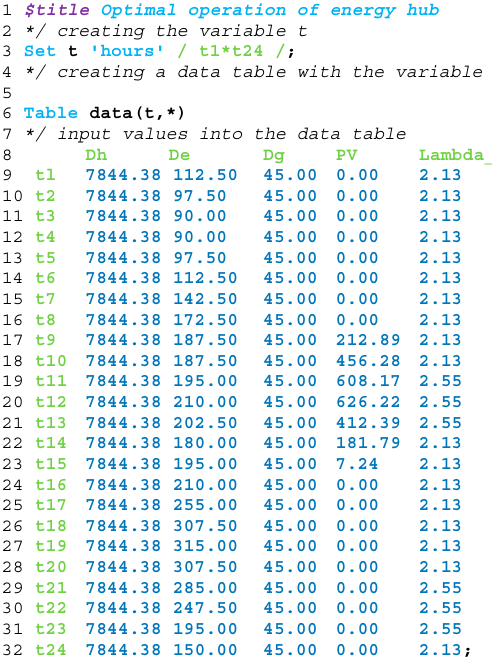
Figure 22. Input data code.